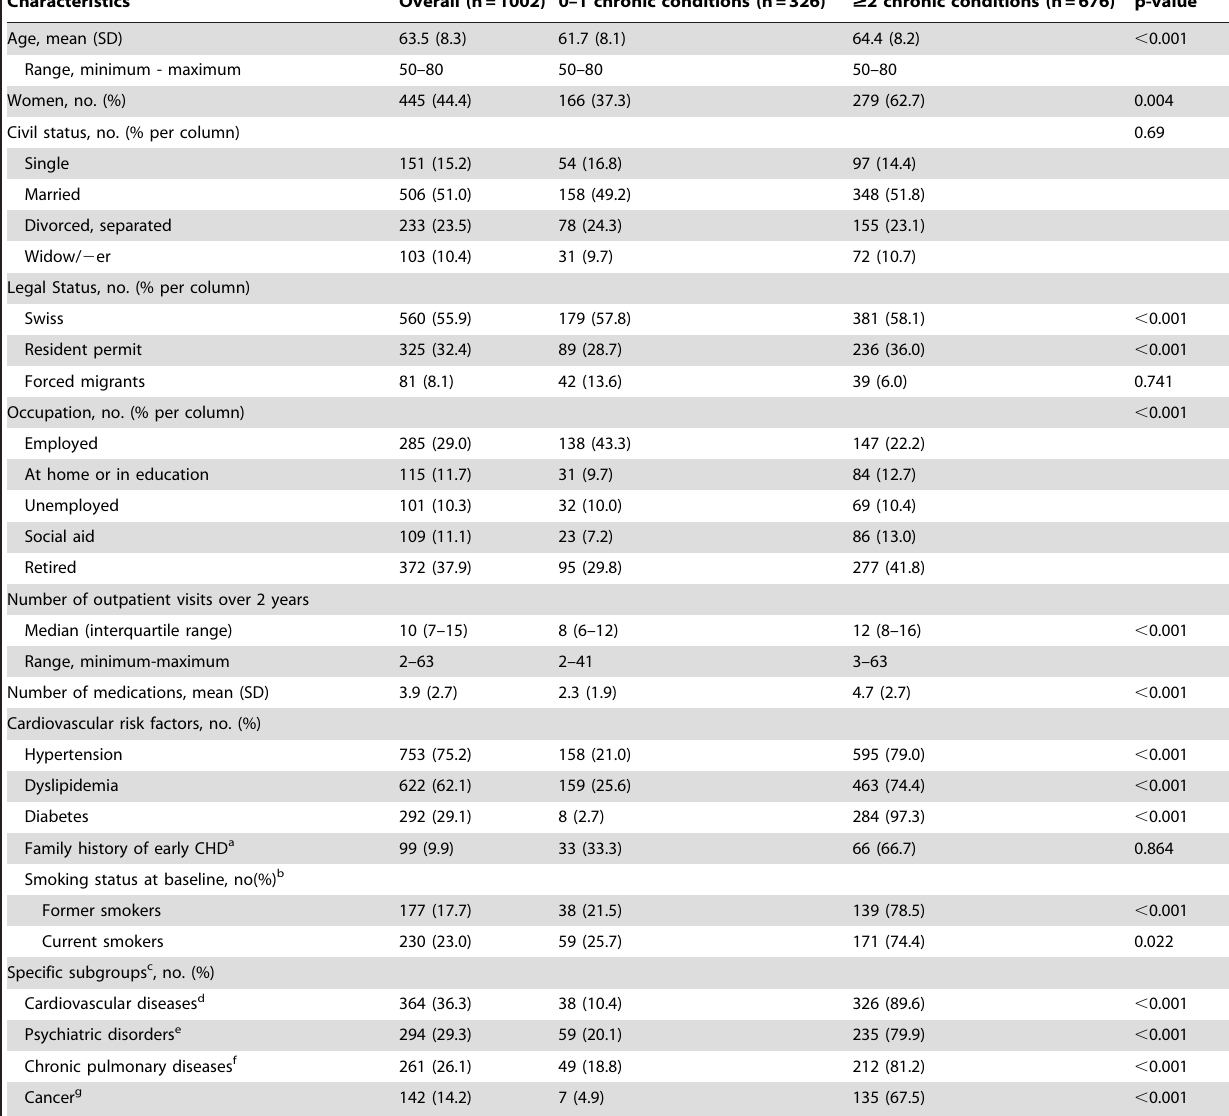
Table 1. Patient characteristics: Random sample of 1002 adults aged 50–80 years in four Swiss university primary care settings.